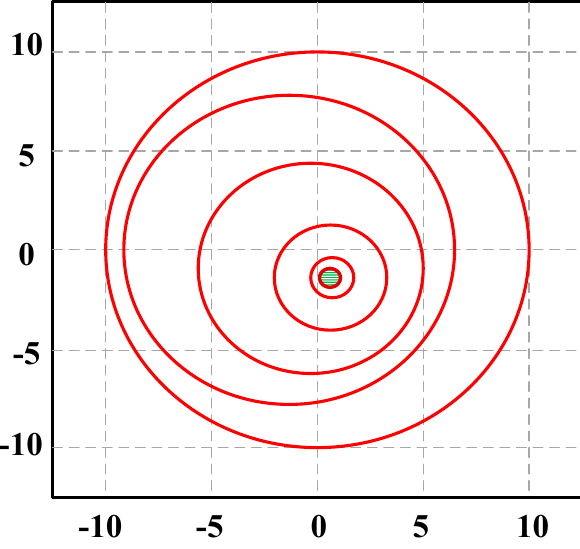
Figure 3. Vortex-pattern search space of the VS algorithm.